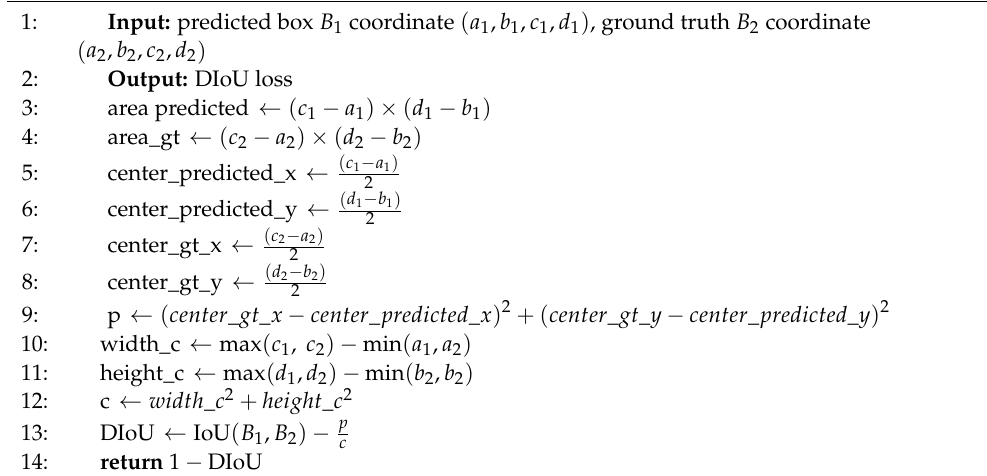
Algorithm 2: DIoU loss function forward